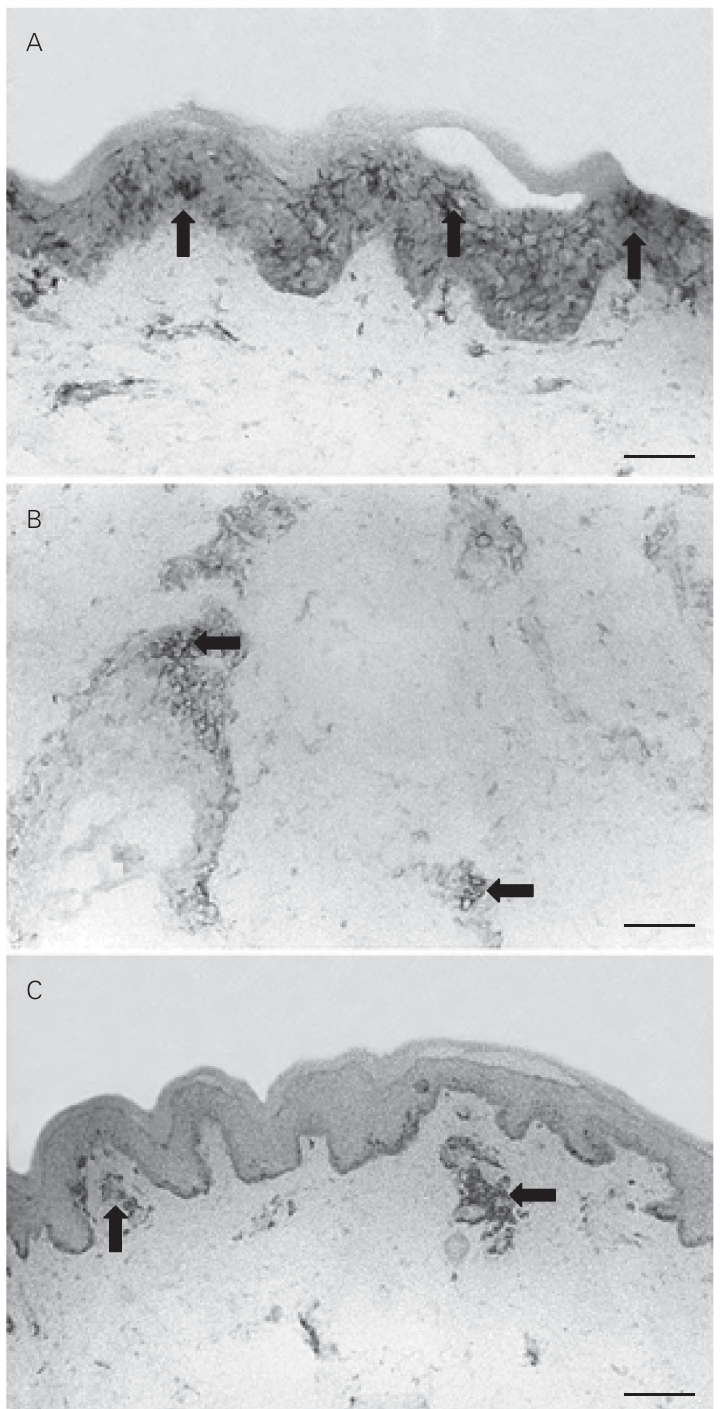
Figure 2. Normal skin biopsies obtained from HIV+ patients. A , There is a diffuse distribu- tion of Langerhans cells (arrows) in the epidermis. Few Langerhans cells are present in the dermis (anti-CD1 staining, 200X). B , CD4 T lymphocytes (arrows) are present in the dermal cellular infiltrate (anti-CD8 staining, 200X). C , CD8 T lymphocytes (arrows) are shown in the dermal cellular infiltrate (anti-CD4 T staining, Original magnification, 200X. Bars = 80